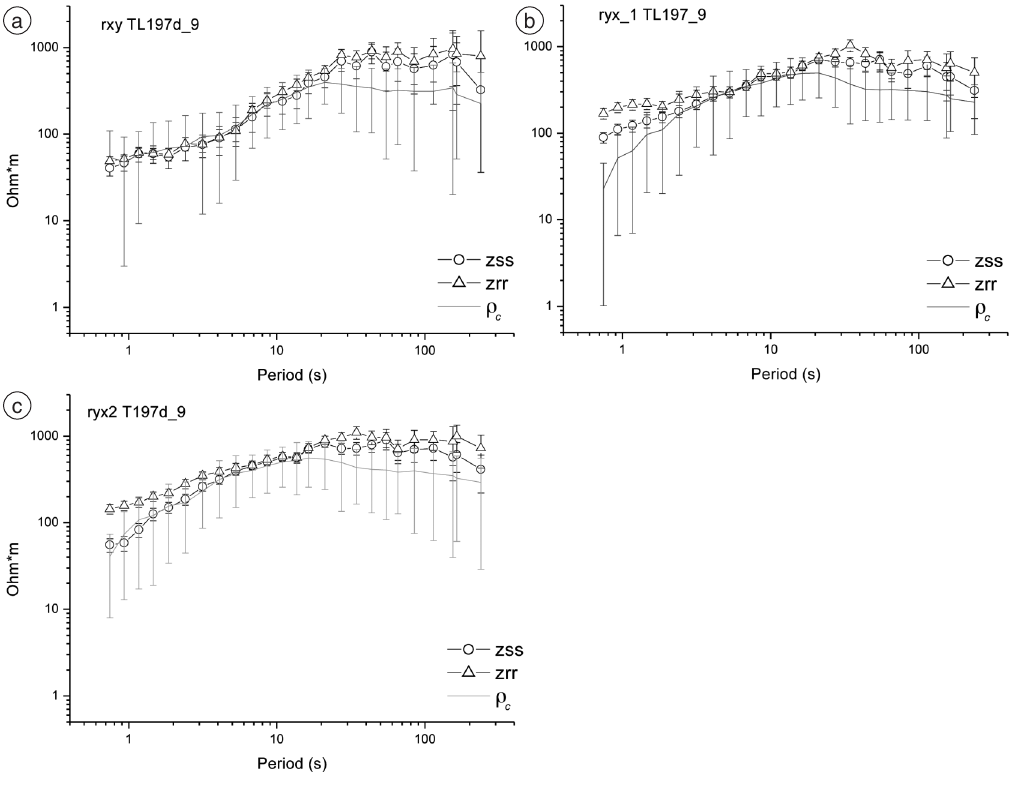
Fig. 7a-c. Comparison between the apparent resistivity curves estimate for the TR site computed with a robust single station method ( zss curve), using MN site as a reference ( zrr curve) for xy component (a), yx 1 component (b), yx 2 component